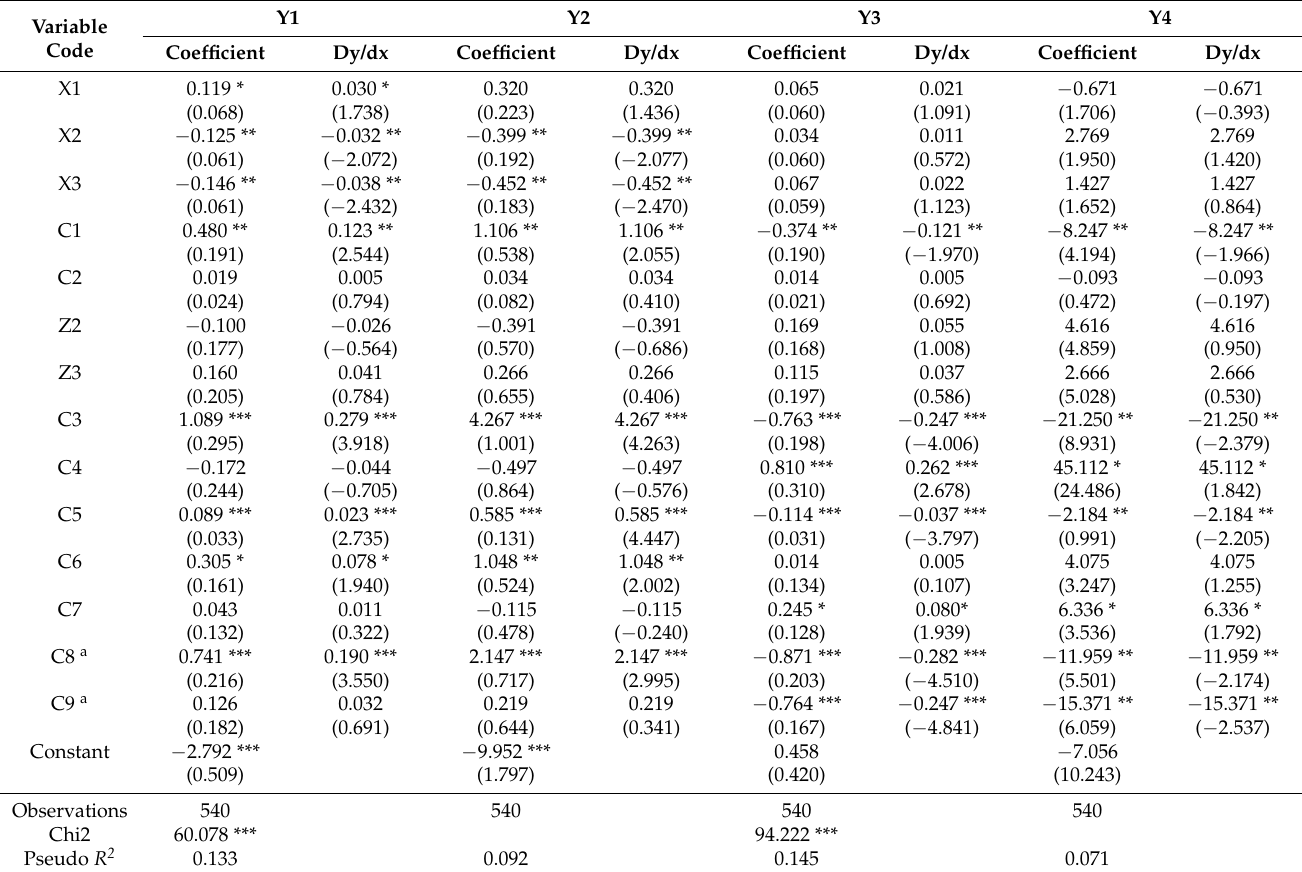
Table 3. The regression results of the impact of land attachment on land